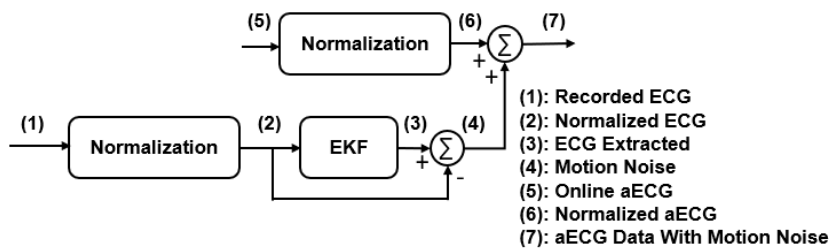
Figure 2. Modified data with motion noise process: ( 1 ) Recorded ECG; ( 2 ) normalized ECG between − 1 and 1; ( 3 ) EKF applied for ECG extraction; ( 4 ) motion noise extracted by subtracting filtered ECG signal from recorded ECG; ( 5 ) online aECG; ( 6 ) normalized aECG between − 1 and 1; ( 7 ) the generated motion noises are added to the online aECG data.